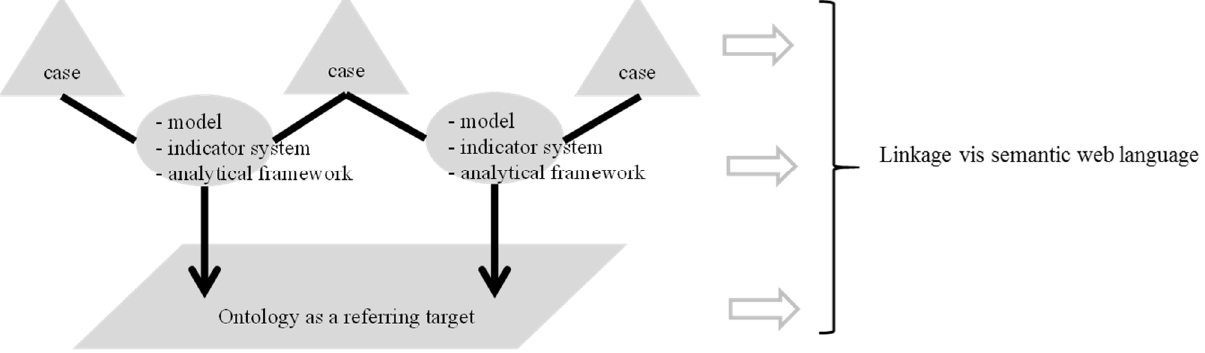
Figure 3. Mutual relationships structured by cases, models and